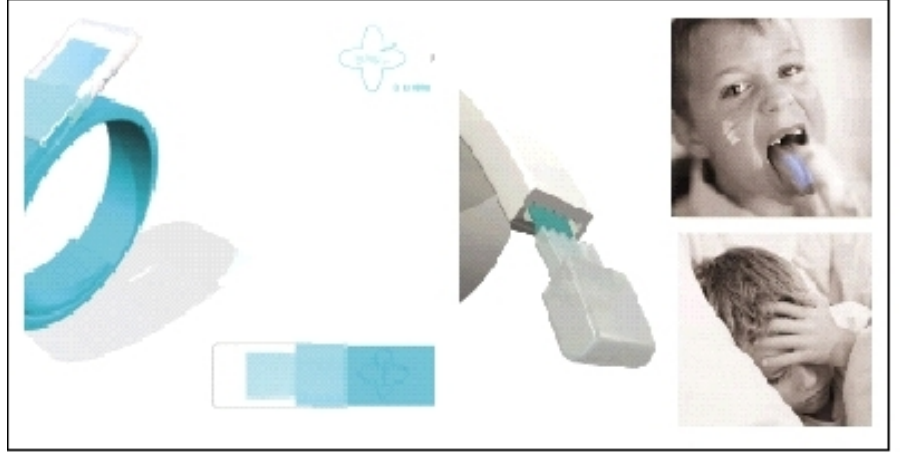
Figure 10. Strip with paracetamol (length of the strip corresponds to the dose).